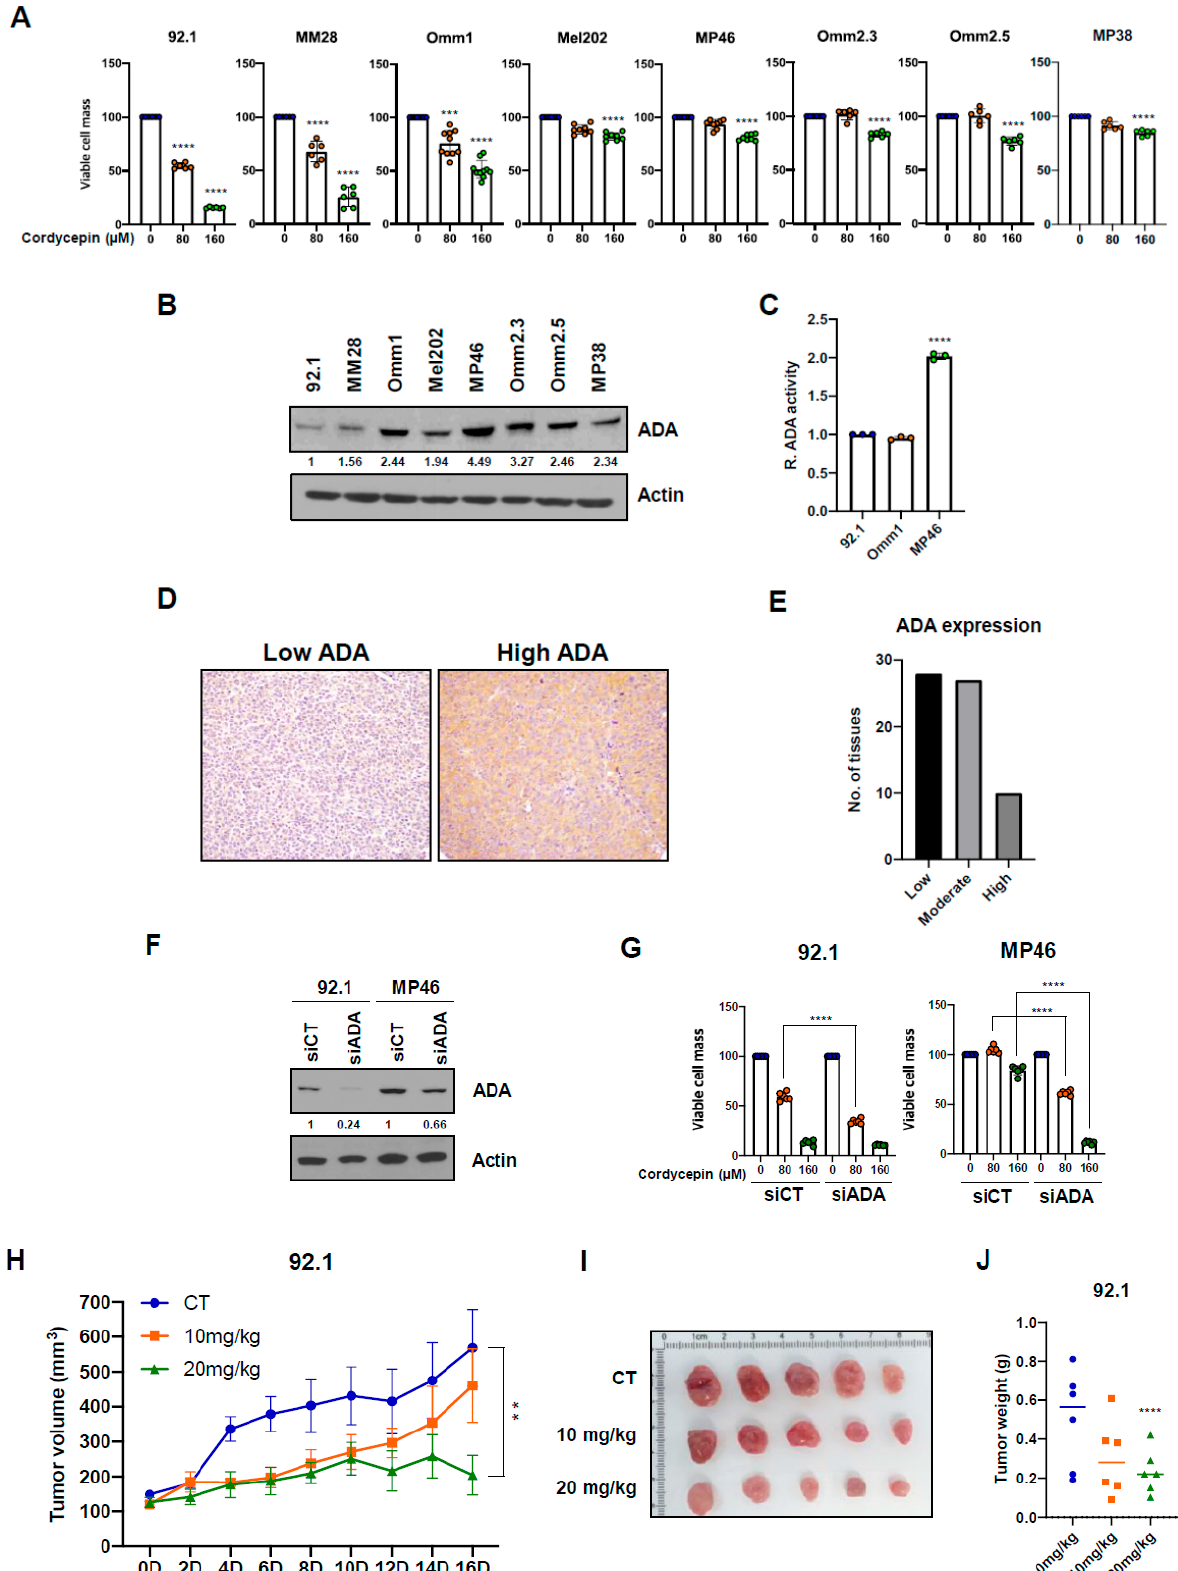
Figure 1. ADA decreases anticancer effects of cordycepin in uveal melanoma. ( A ) Growth of viable cell mass after cordycepin treatment. Uveal melanoma cells were treated with vehicle, 80, and 160 μ M of cordycepin, and after 5 days incubation viable cell mass was measured using fluorescence.